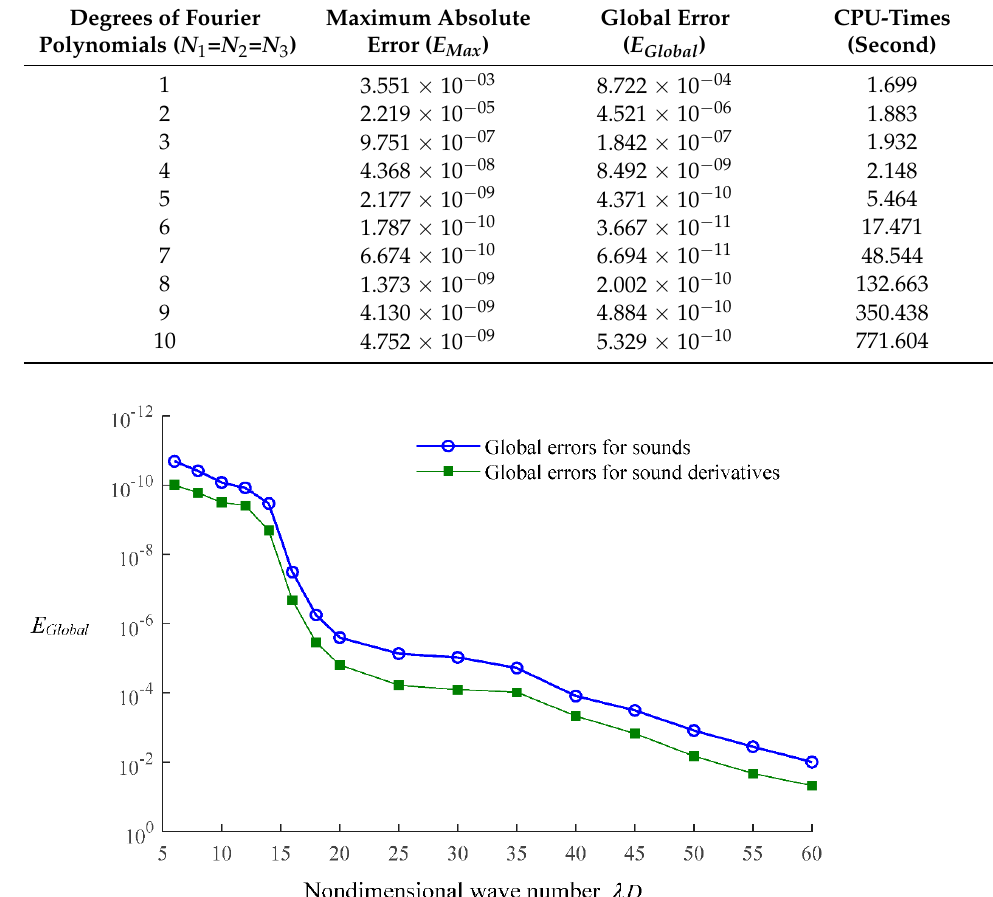
∂ ∂ Figure 10. Relative error curves of u and ∂ u / ∂ x 1 with respect to different values of non-dimensional Figure 10. Relative error curves of u and 1 / u x with respect to different values of non-dimen- wave number λ D sional wave number D λ .